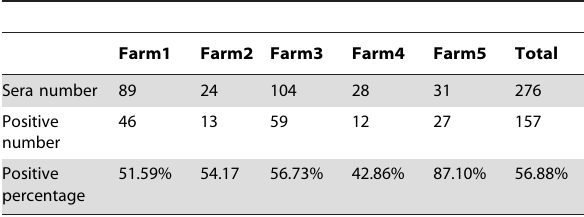
Table 2. Detection of HEV antibodies in swine sera in Hebei province, China.